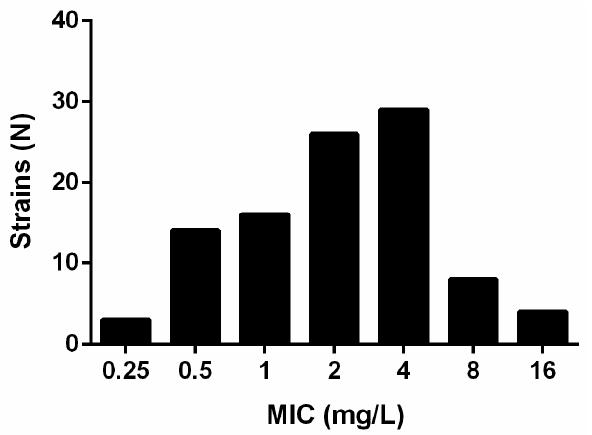
Figure 1. MIC (mg/L) distribution of N = 100 Stenotrophomonas maltophilia strains for gepotidacin as found in broth microdilution after EUCAST.